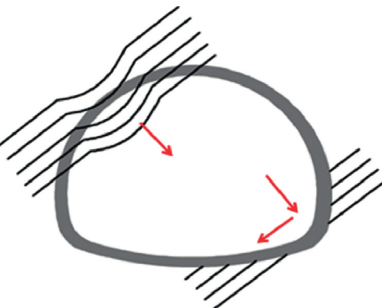
Figure 11: Transverse shear slip deformation (arrow indicates the direction of